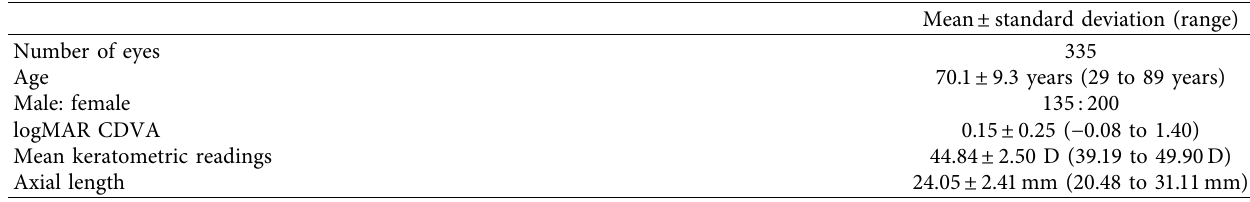
Table 1: The preoperative demographics of the study population undergoing cataract